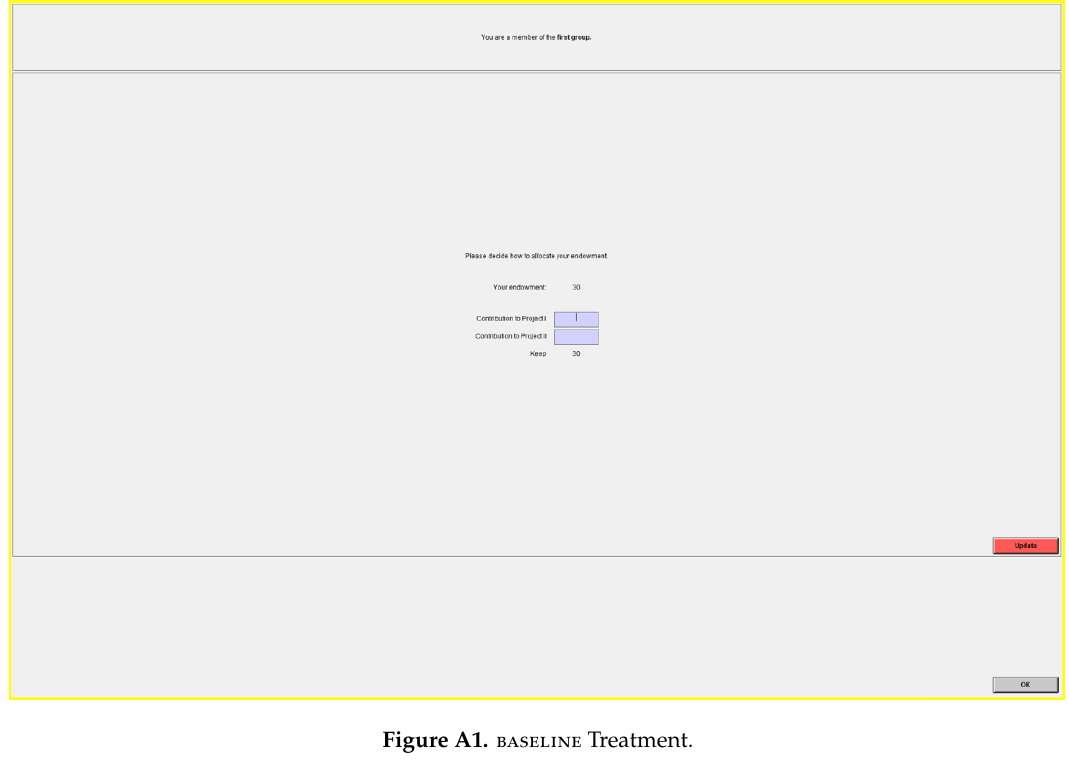
Figure A1. BASELINE Treatment. Figure A1. baseline Treatment.